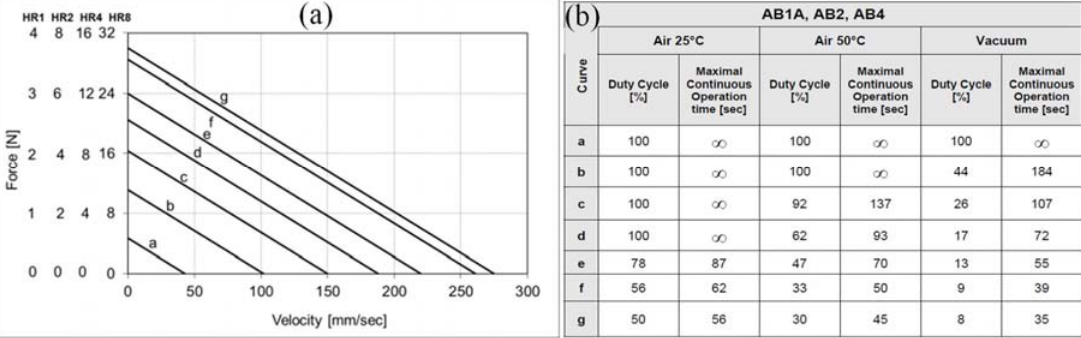
Figure 7. Envelope of performance of L1B2 motors from Nanomotion HR motor series, when driven by AB1A driver [17]: ( a ) Force—velocity curves, for Nanomotion HR-type motors; ( b ) maximal duty cycle for operation in air and vacuum, for operating at force-velocity combinations, located below each of the force velocity curves shown in ( a ).